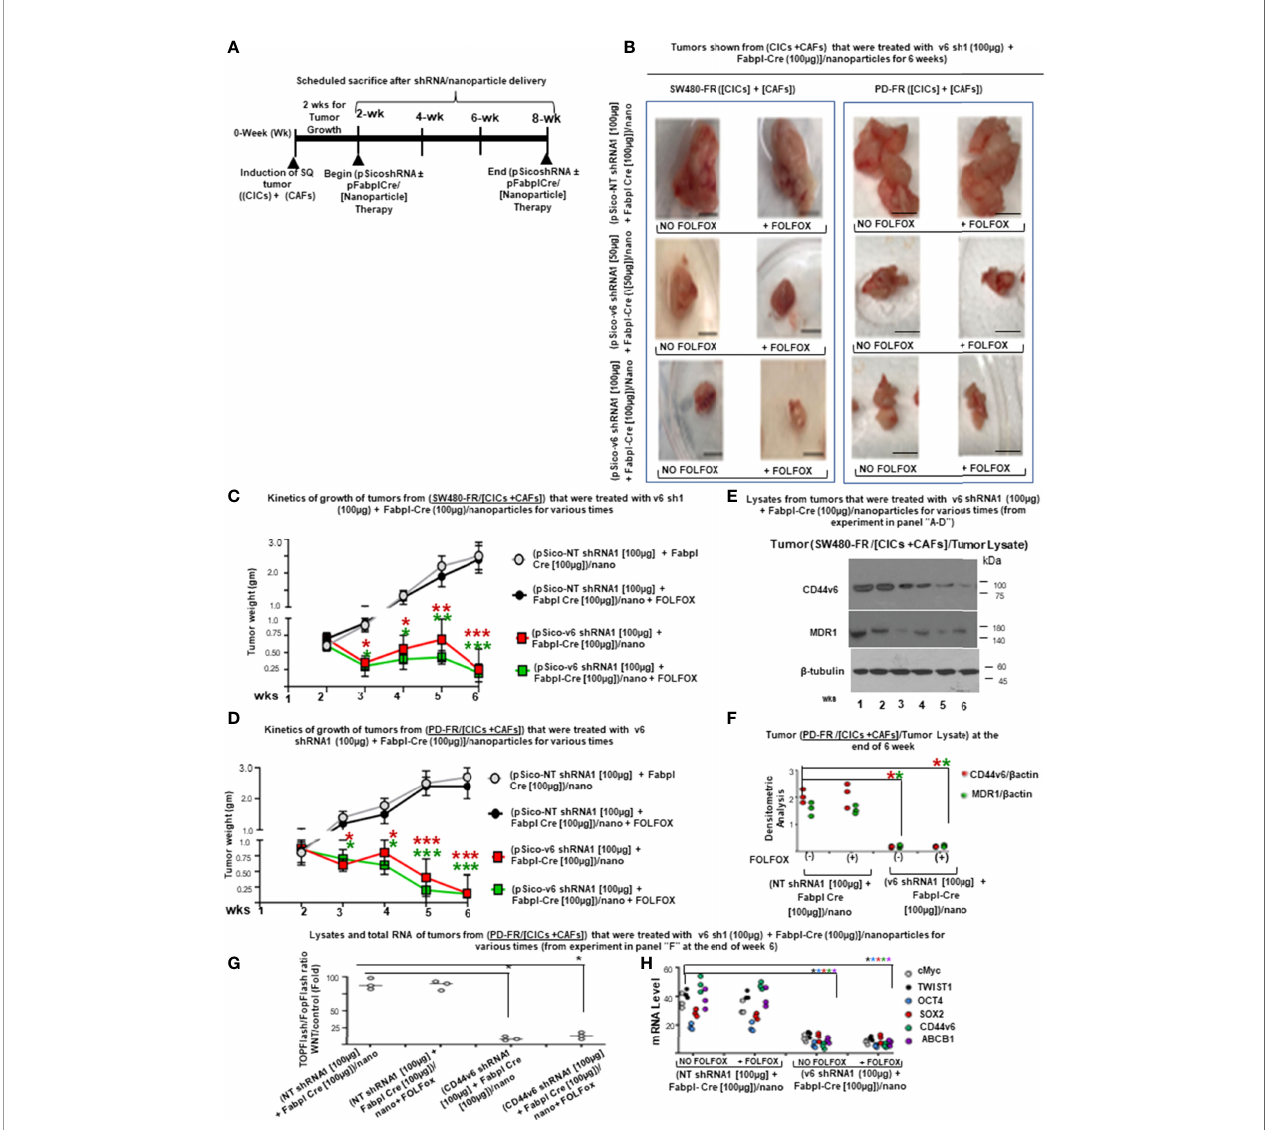
FIGURE 10 | Tissue speci fi c knockdown of CD44v6 by pFabpl-Cre inhibits subcutaneous (SQ) tumor growth of implanted CICs plus CAFs from SW480-FR/SQ tumors and from PD-FR/SQ tumors. (A) , Timeline is shown for pSico-v6-shRNA/Nano particle treatment with and without pFabpl-Cre/Nano in xenograft tumors derived from CICs plus CAFs from SW480-FR/SQ tumors and PD-FR/SQ tumors. (B) , The dependence of tumors derived from CICs and CAFs on CD44v6 was evaluated in vivo. 2 x 104 FACS sorted CAM(+)CD44v6(+)CD133(+)ALDH1(+) CICs and 6 x 104 CAFs (EpCAM [-]/PDGFR- a were injected into mice. When tumors reached to approximately 0.3 cm3 in volume, treatment was initiated. Detailed treatment procedure is in Methods. Seven immunocompromised mice per group were used. Mice were weighed every other day, and the tumor weights were measured every week for 4 weeks. Representative tumors following sacri fi ce from three experiments are shown from mice treated as indicated in the schedule of treatment (A) . (C, D) , Kinetics of relative tumor weights with time are shown during in vivo SQ tumor growth at the indicated weeks that were generated by CICs plus CAFs from SW480-FR/SQ tumors (C) and from PD-FR/SQ tumors (D) injected (i.p.) with pSico-NT shRNA/Nano, pSico-v6 shRNA/Nano, and (pSico-v6 sh plus